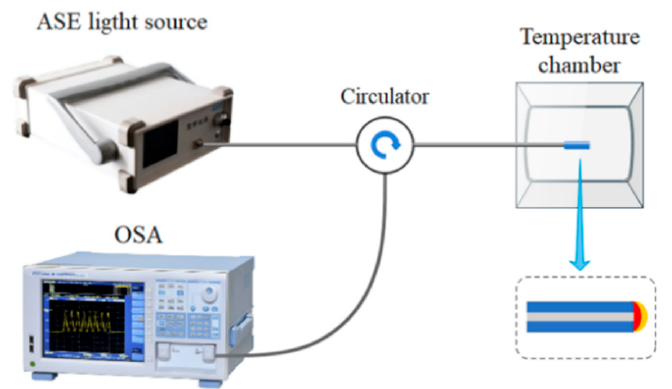
Figure 5. Temperature detection system.